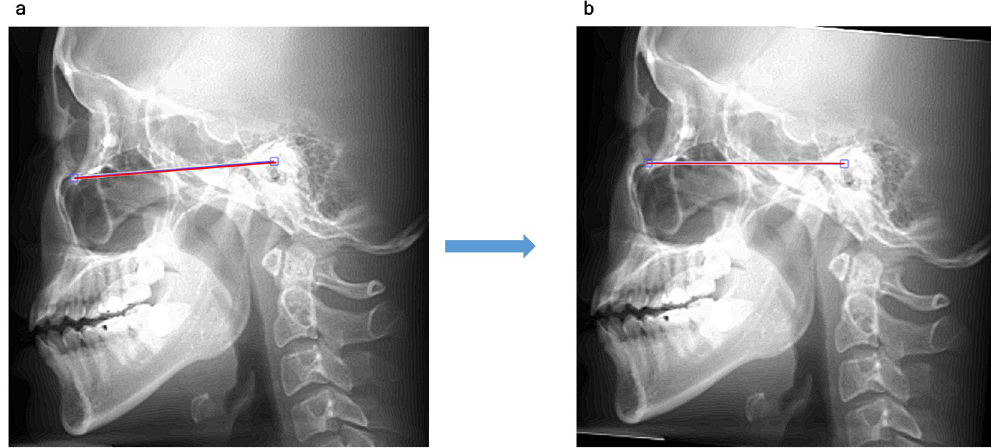
Figure 2. Image reorientation (sagittal). ( a ) Using the average intensity projection image in the sagittal direction, a Frankfort plane (red segment) was drawn passing through the 2 points defined by the inferior margin of the orbit and the upper margin of the external auditory meatus. ( b ) The entire image was rotated around the center of the two points for the Frankfort plane to be parallel with the